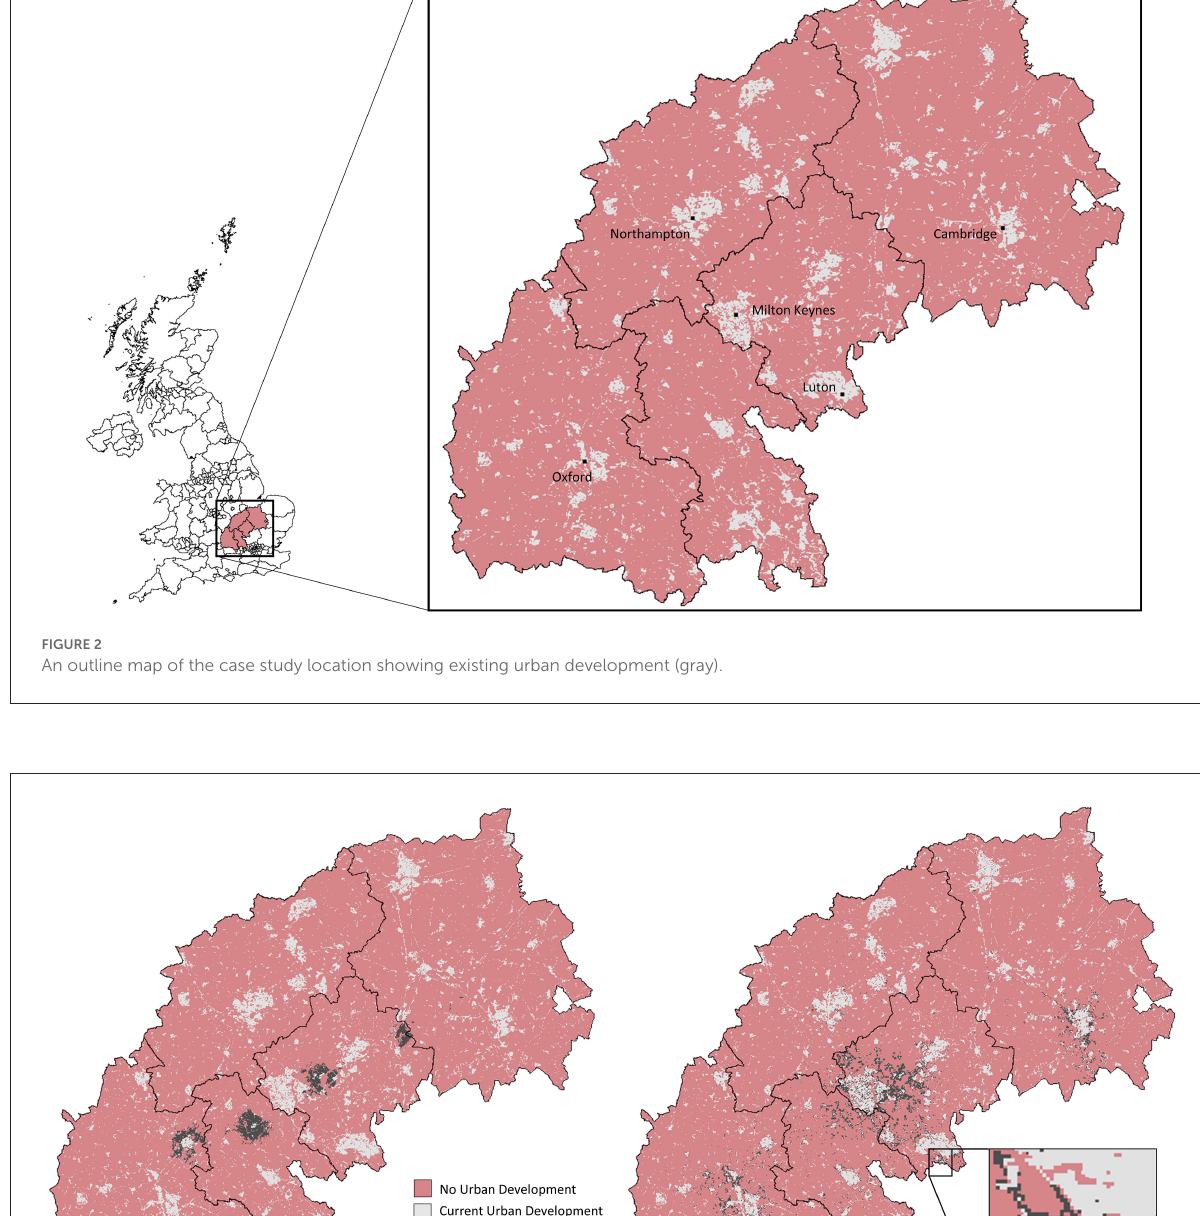
These urban tile designs were assigned to each pixel of the UDM output for each scenario as follows. A blank tile (i.e., 100% greenspace) was assigned to each 0-value pixel.